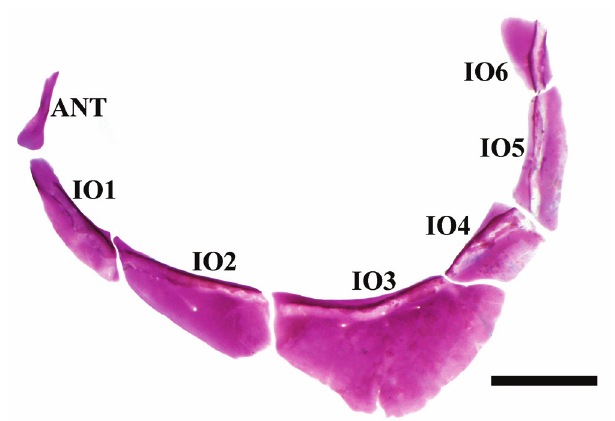
Fig. 4. Moenkhausia doceana , MBML 5883, 51.6 mm SL . Antorbital (ANT) and infraorbital bones (IO1-6); left lateral view. Scale bar = 2 mm.